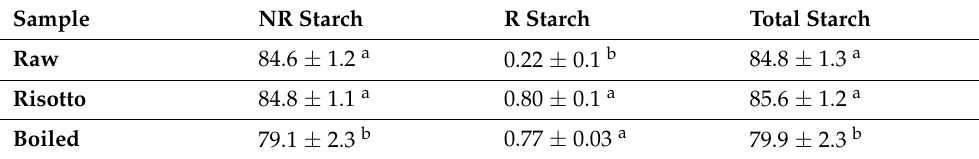
Table 3. Nonresistant (NR), resistant (R), and total starch in raw and cooked “Gigante Vercelli” white